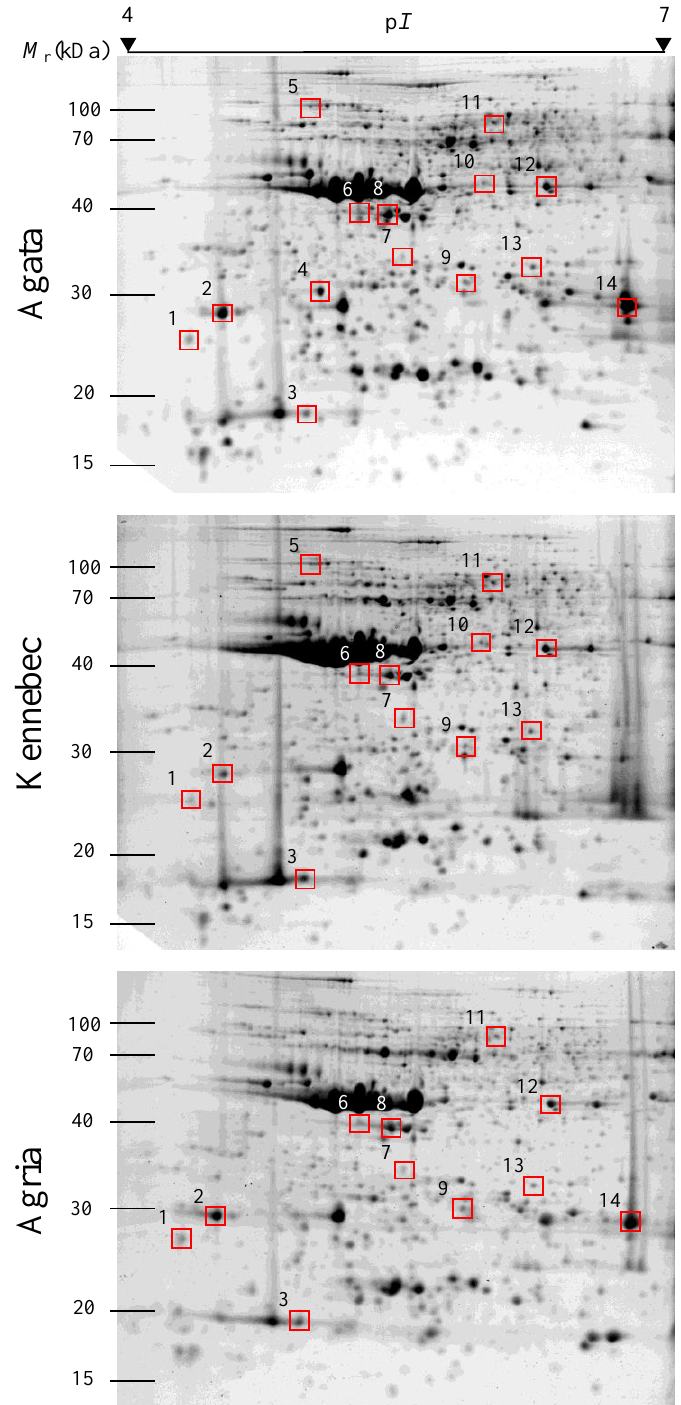
Figure 2. Two-dimensional electrophoresis gel images of global endodormancy proteomes from three potato cultivars (Agata, Kennebec and Agria) at the endodormancy stage. Squares indicate the fourteen spots that house a single differentially abundant protein between cultivars according to LC-TripleTOF MS/MS analysis.